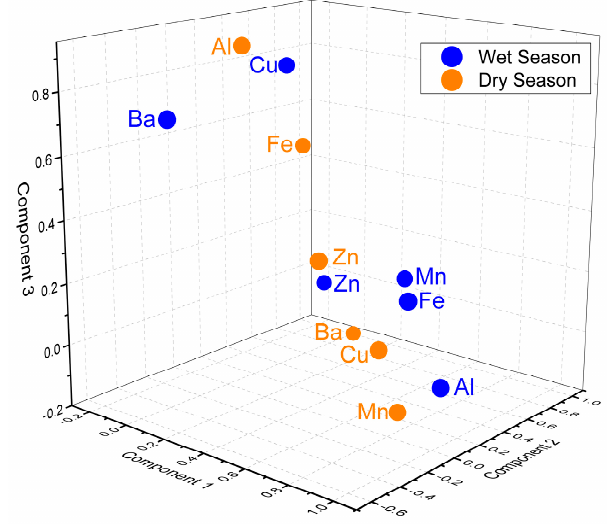
Figure 5. Loading plot of dissolved heavy metals in the Mun River.